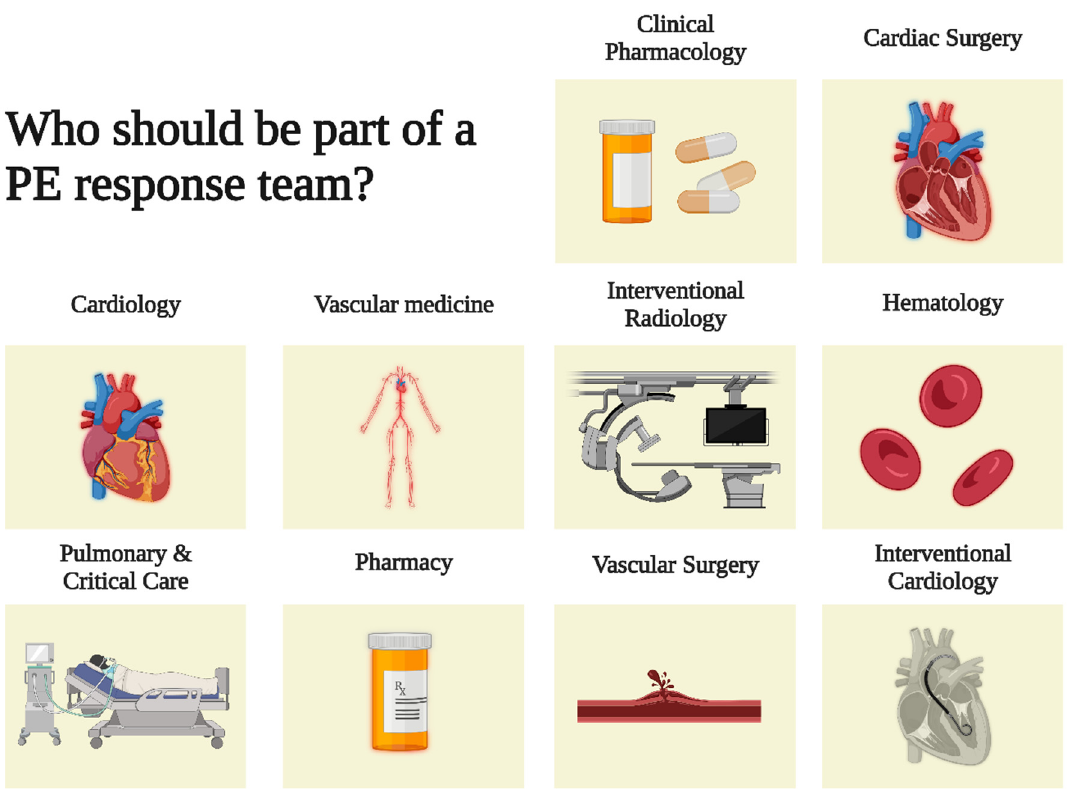
Figure 2. The rationale for a PE response team. PE = pulmonary embolism.